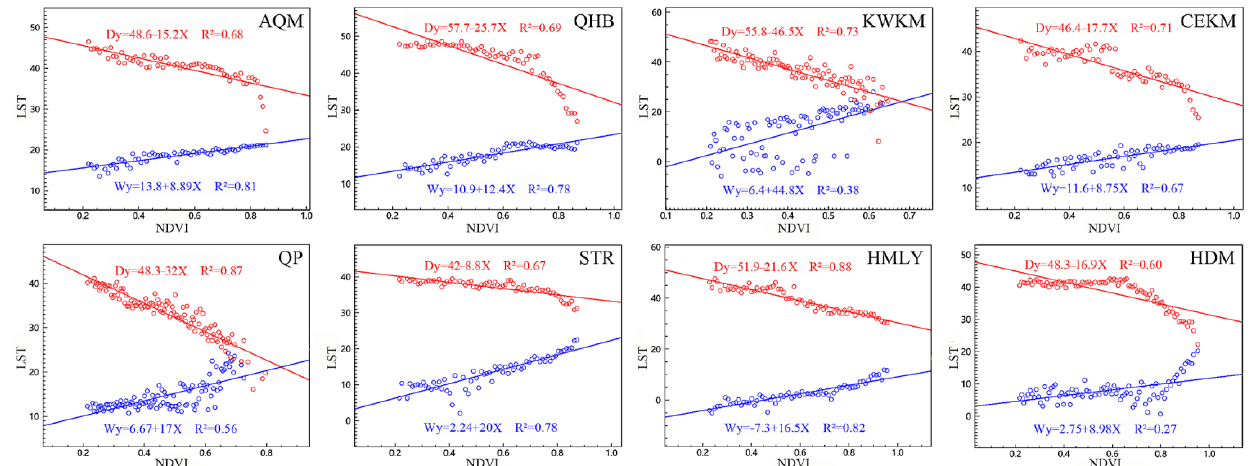
Figure 5. NDVI-LST spatial characteristics of eight geomorphological divisions of the QTP (taking 2001 as an example)(The horizontal axis represents NDVI. The vertical axis represents LST. The blue line is the fitted wet edge equation. The red line is the fitted dry edge equation. The sample points are represented by small hollow circles.)